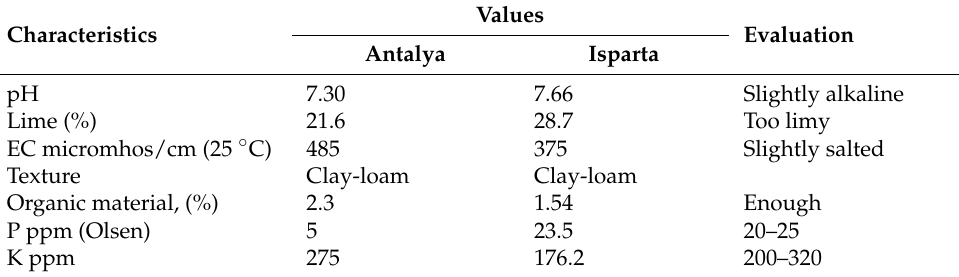
Table 1. The chemical and physical properties of soil in the experiment